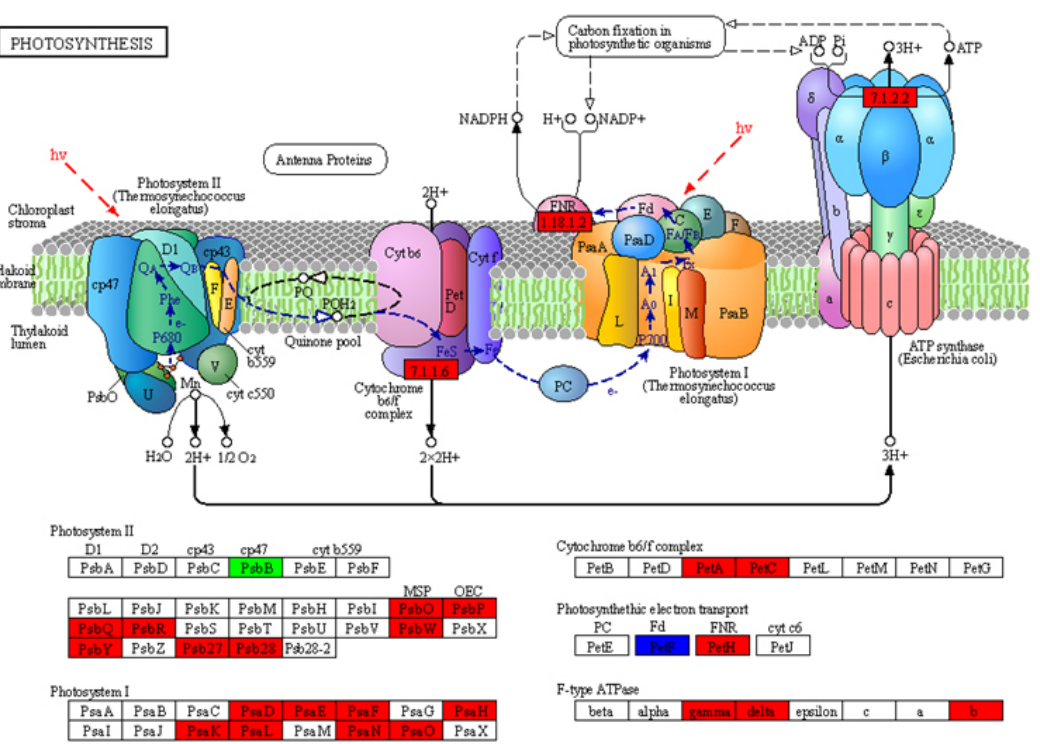
Figure 6. The KEGG map of the photosynthesis pathway in the non-transgenic plants versus the transgenic plants. The red means the DEGs were up-regulated, the green means the DEGs were down-regulated, and the blue means both up- and down- regulated.